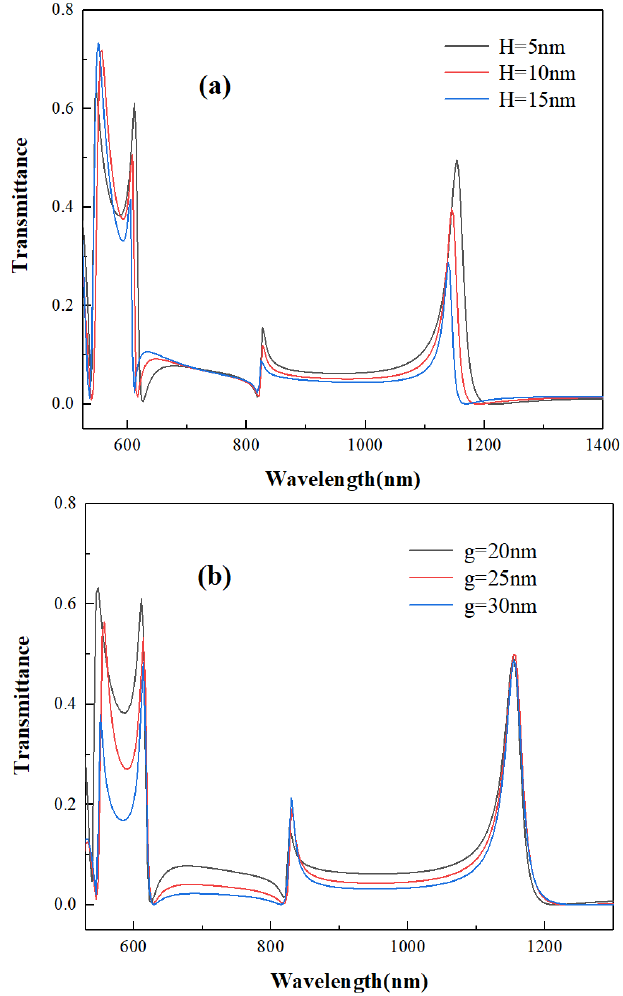
Figure 7. Transmission spectra of the structures with different ( a ) coupling distances. ( b ) Silver baffle widths.